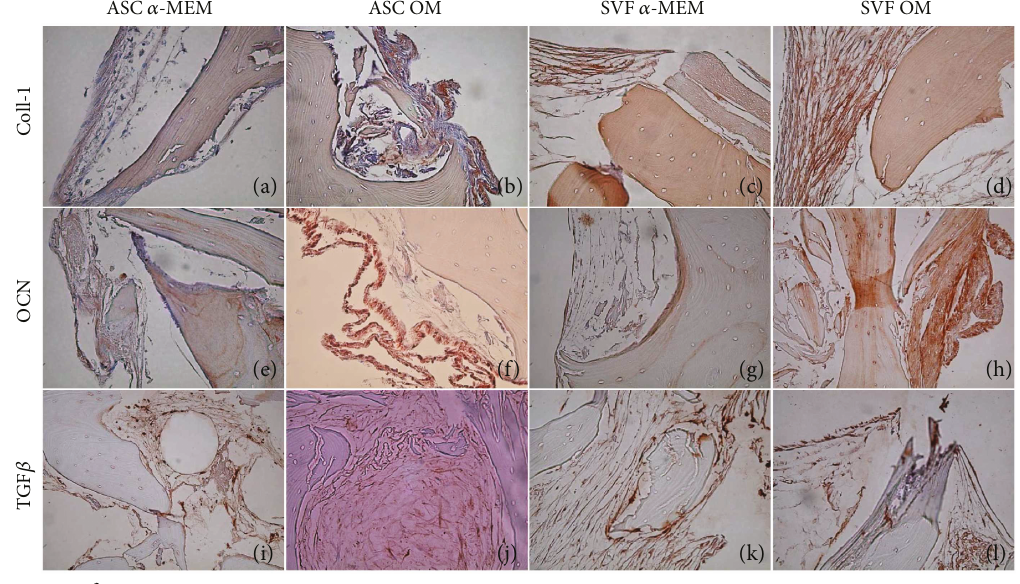
Figure 7: Osteoblast di ff erentiation of ASCs and SVF on SmartBone. At 60 days, in ctrl condition, collagen I (COLL I) was weakly positive on SmartBone cultured with ASCs (a), whereas in culture with SVF, COLL I was expressed (c). Both in cultures with ASCs and SVF with osteogenic medium (OM), COLL I markedly stained the new tissue on SmartBone (b, d). Osteocalcin (OCN) was weakly positive in ctrl (e, g), and it was highly expressed with OM, mainly on the periphery of the newly formed tissue (f, h). TGFb stained osteoblasts at the margin of the newly formed tissue both with and without OM, with ASCs and SVF (i – l). Magni fi cation: